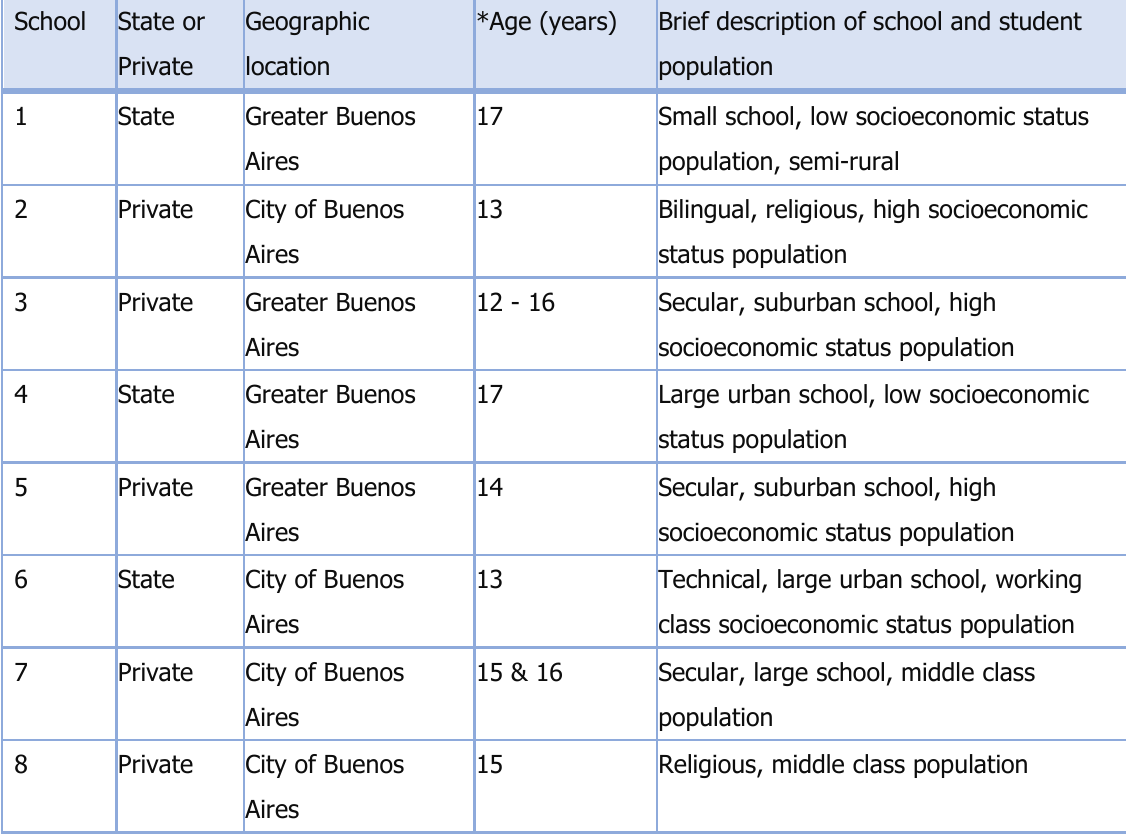
Table 1: Summary of School Characteristics